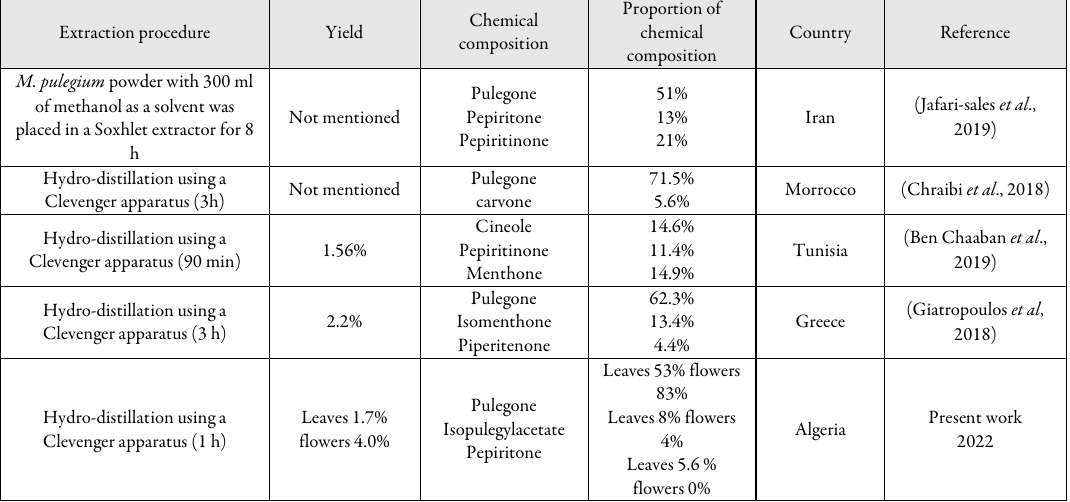
Extraction procedure